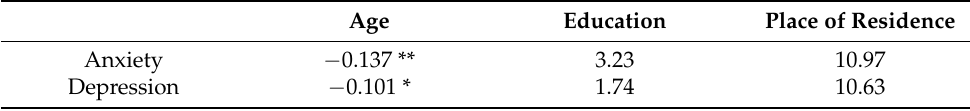
Table 2. Correlations between the HADS scores and